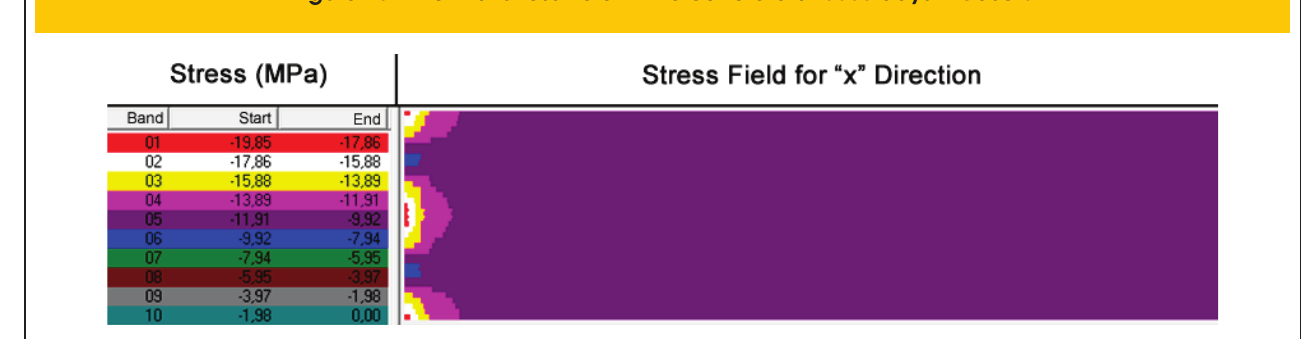
Figura 13 – Normal stress field in the concrete at 3000 days – Case